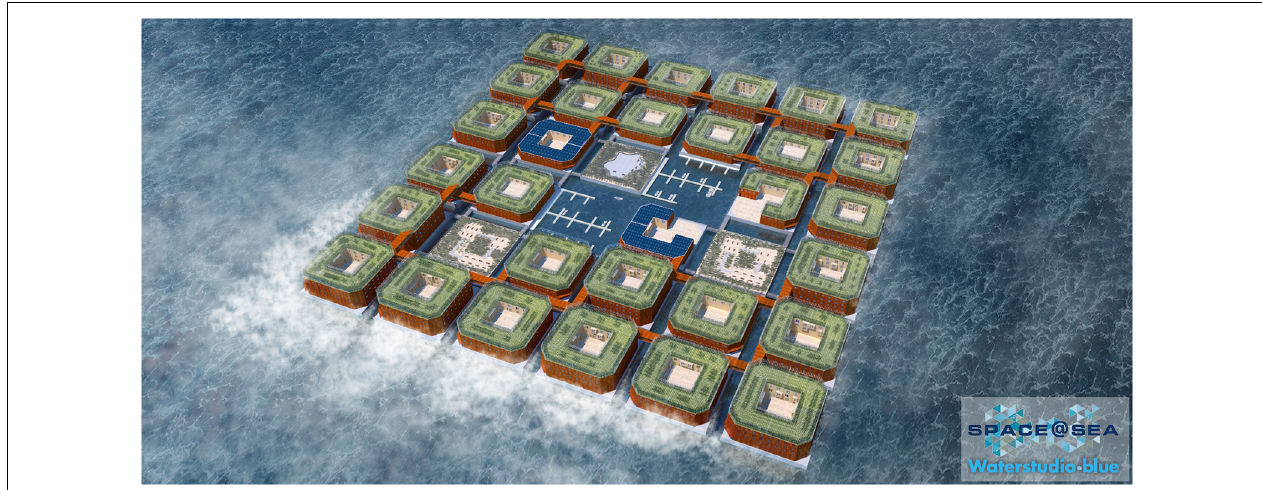
FIGURE 1 | Impression of a floating island. A floating island can be made of any material and have an arbitrary shape and floater type. The most obvious material is concrete, or steel and the shape of the top view is reckoned to be square or rectangle. For floater types semi-submersibles and barges make most sense. Any other materials, shapes or floater types, however, do not disregard the object to be called a floating